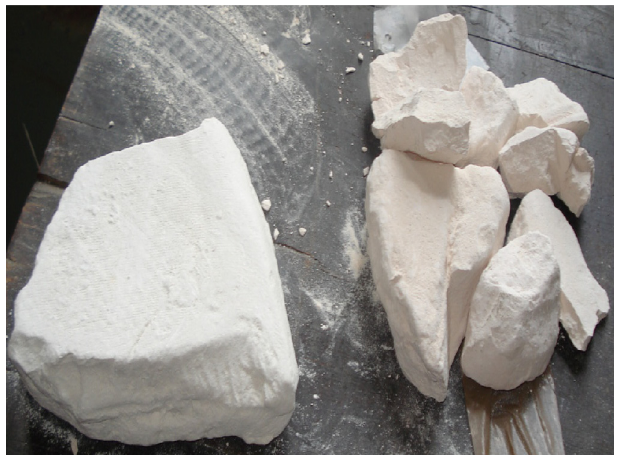
Figure 1. Kaolin clay ( Left ) and metakaolin ( Right ).